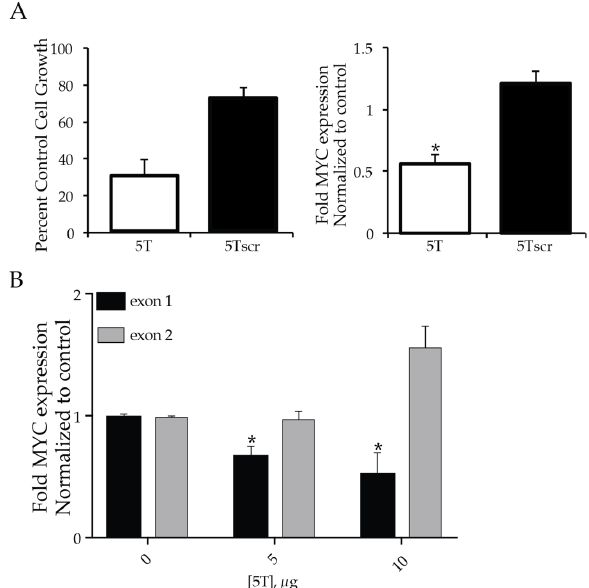
Figure 4. Efficacy of DNAi 5T in Burkitt’s lymphoma cell lines. ( A ) DNAi 5T or 5Tscr (500 ng) was incubated with RAJI cells for 24 h and the effects on cell viability (left) or MYC regulation (right) were measured. 5T, but not 5Tscr, decreased both RAJI cell viability and MYC mRNA